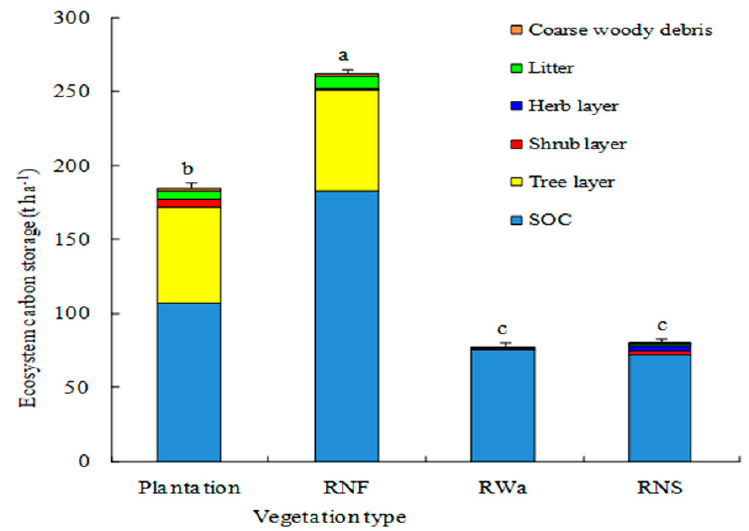
Figure 4. Ecosystem carbon storage of different vegetation types, including soil organic carbon (SOC), tree biomass carbon, and secondary biomass carbon.